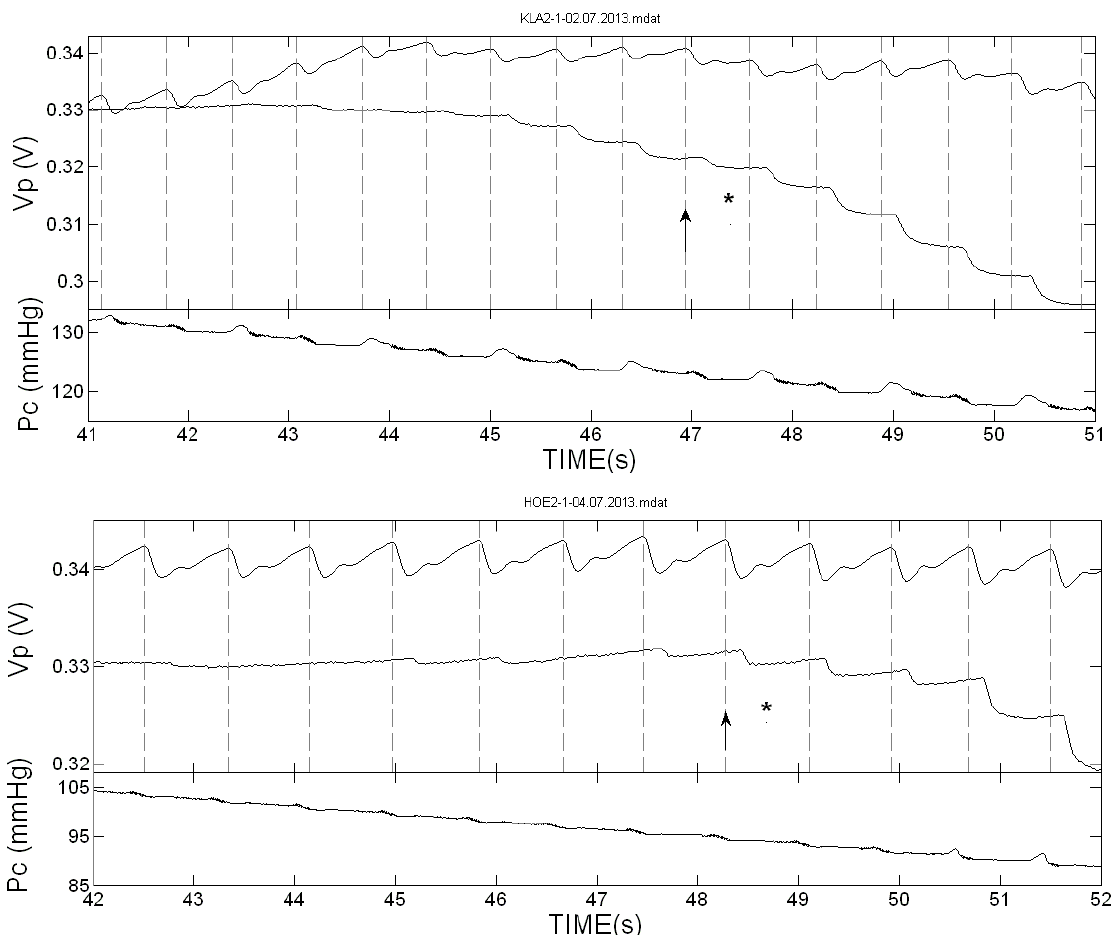
Figure 4. The PPG pulses in the two hands of two of the subjects during cuff deflation for cuff pressures in the neighborhood of the SBP value, and the cuff-pressure P the star indicates the time of the first detection of the Korotkoff sounds and the arrow indicates the start time of the free-hand PPG-pulse in which the first star appeared. In these examinations, the PPG pulses reappeared several pulses before the detection of the first Korotkoff sound (indicated by the star). In these examinations the PPG technique is more reliable than Korotkoff sounds